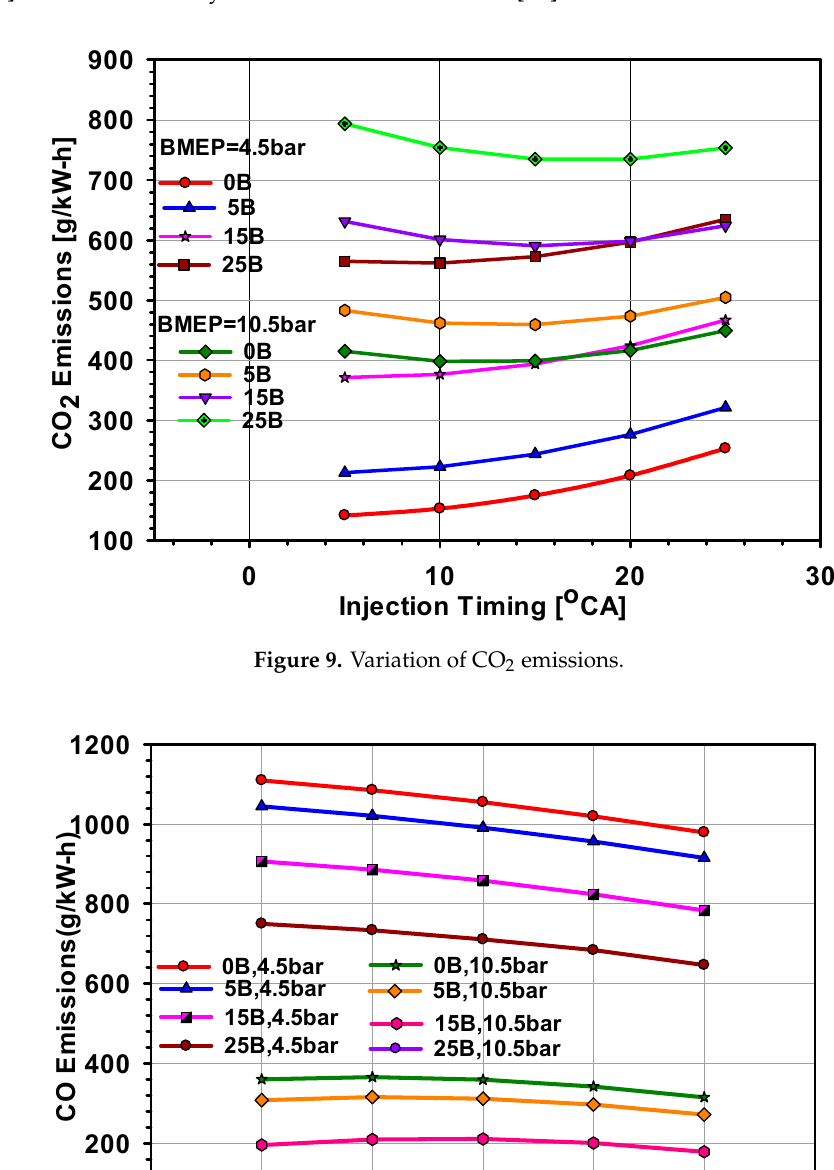
Figure 10. Variation of CO emissions.